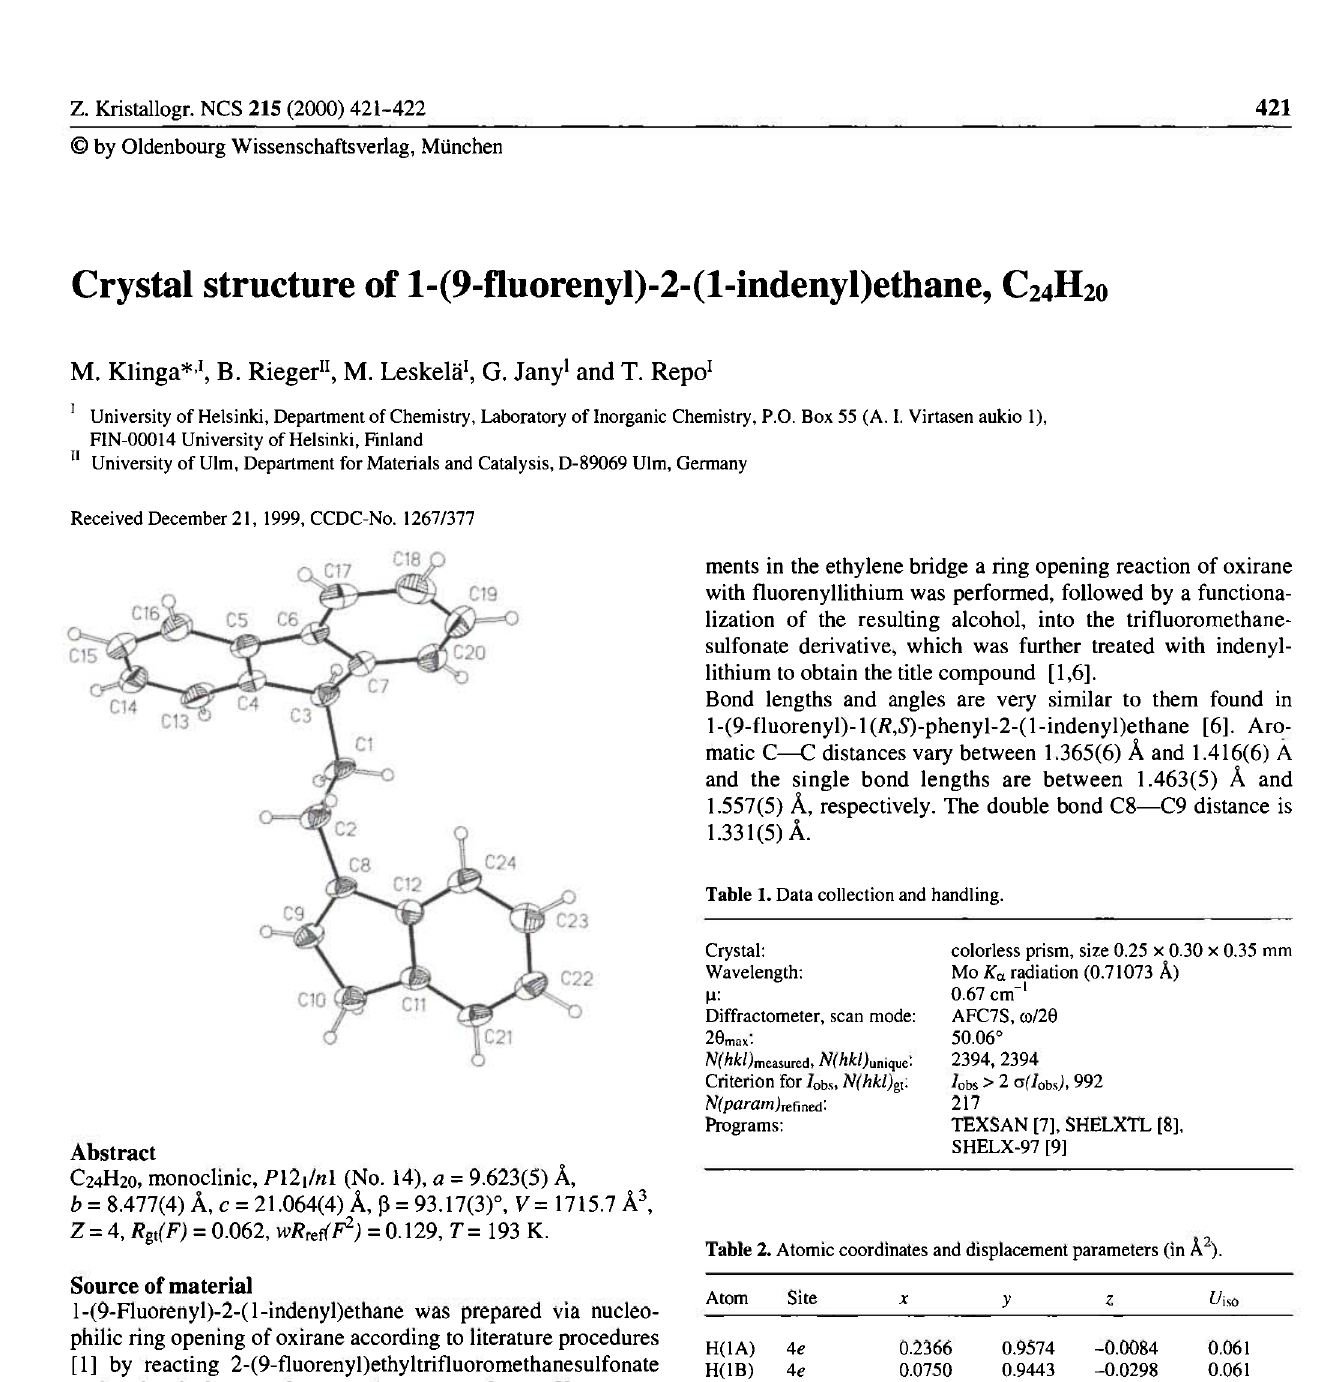
Table 2. Atomic coordinates and displacement parameters (in Ä 2